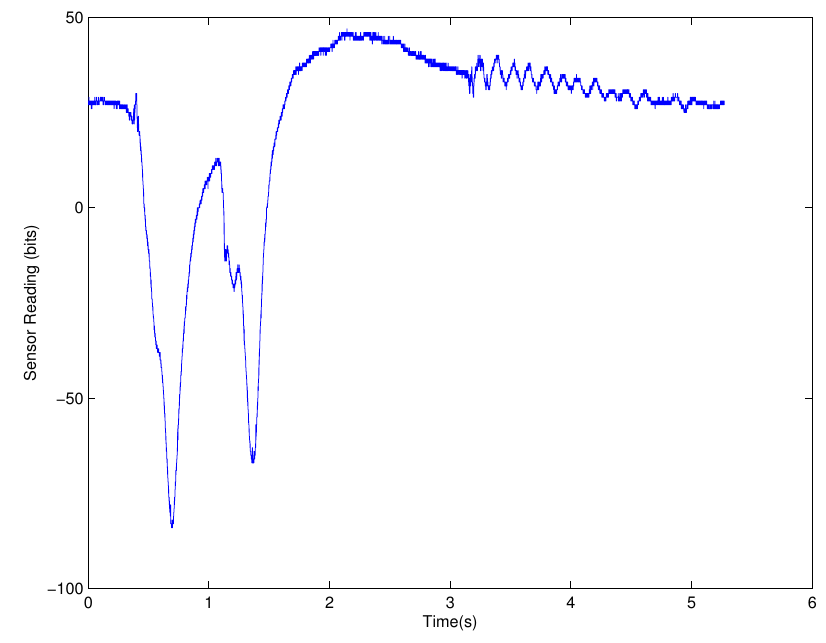
Sensor measurements from test using robotic arm with collision and emergency